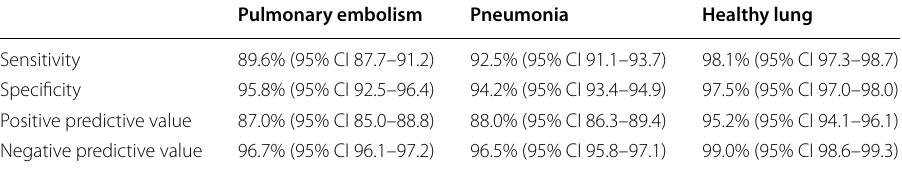
Table 5 Sensitivity, specificity, PPV and NPV statistics for the leave‑1‑out training of the best AUC